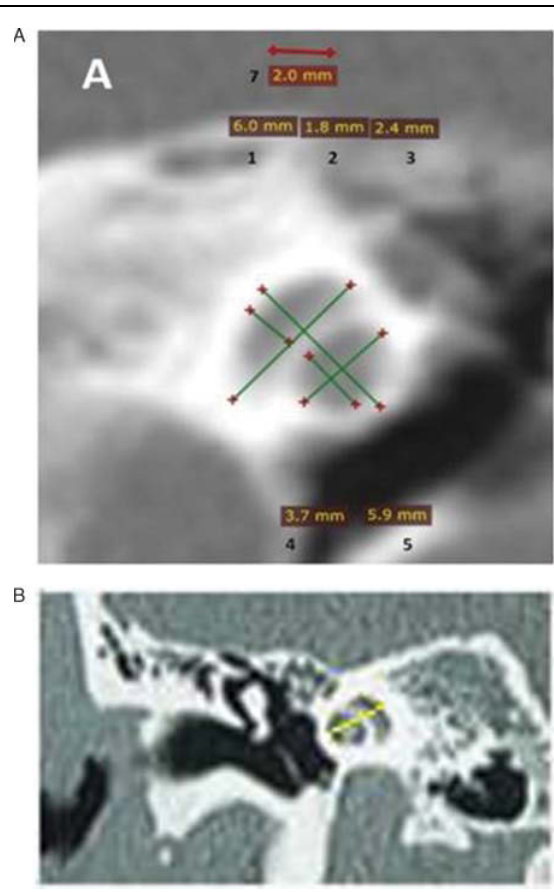
Coronal computed tomography of the cochlea showing measure- ments in (a) normal cochlea, (b) miniature cochlea, representing cochlear height